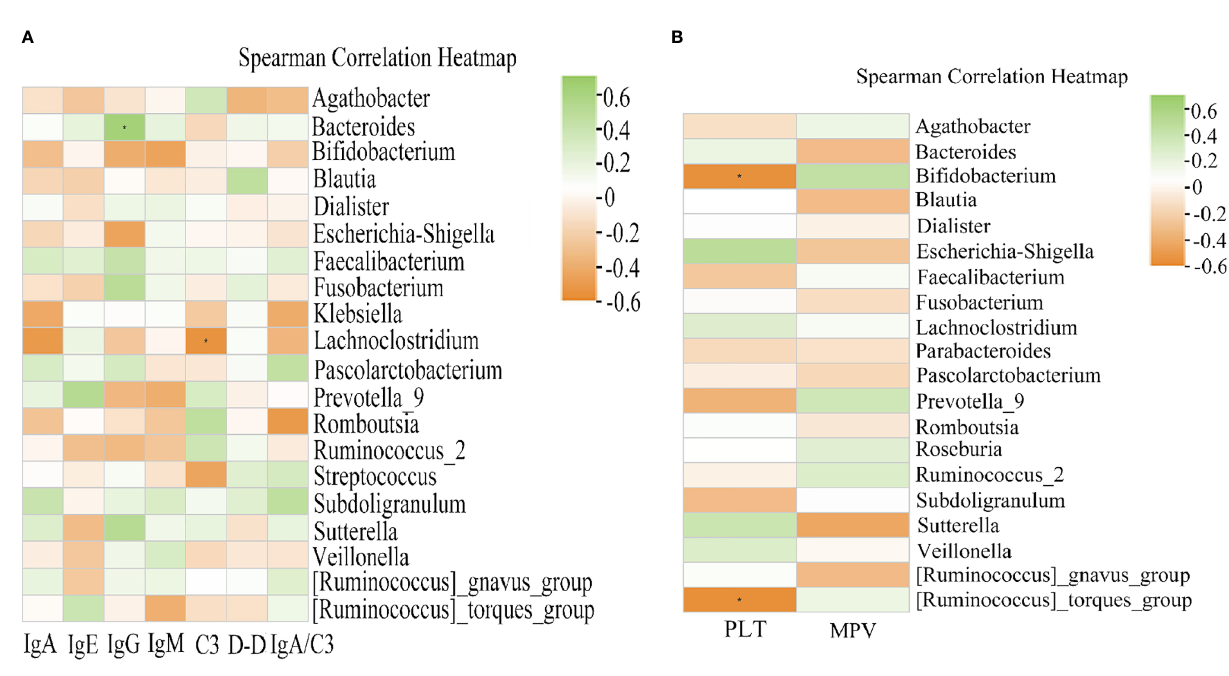
FIGURE 7 | Heat map of Spearman correlation analysis between the gut microbiota and clinical indices of HSP. (A) Correlation between the relative abundance in HSP groups and the clinical indices. IgG exhibited a signi fi cant positive correlation with the genus Bacteroides (r = 0.5347, P < 0.05). C3 was negatively correlated with Lachnoclostridium (r = -0.5523, P < 0.05). (B) Correlation between the relative abundance of gut microbiota and the clinical indices in recurrent HSP. Spearman analysis showed a strong negative correlation between the platelet count and Bi fi dobacterium ( r = -0.5533, P < 0.05) and Ruminococcus_torques_group (r = -0.5659, P < 0.05). Green and orange represent positive and negative correlations, respectively. * P <